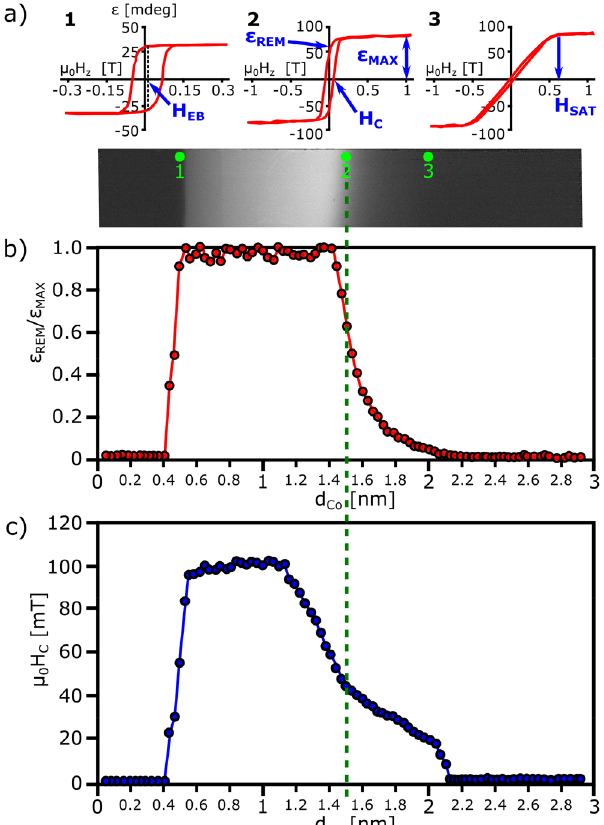
Figure 1. Results of PMOKE measurements. ( a ) Differential PMOKE microscope images registered in remanence after saturation with an out-of-plane magnetic field, where the bright area corresponds to the part of Co layer with PMA. This panel additionally shows the exemplary PMOKE hysteresis loops measured for d Co = 0.5, 1.5, 2 nm (green dots 1 to 3, respectively). On that loops the definitions of characteristic parameters: remanence ( ɛ REM ), ellipticity in maximal magnetic field ( ɛ MAX ) and saturation field ( H SAT ) and exchange bias field ( H EB ) are given graphically; ( b , c ) d Co dependencies of normalized Kerr signal ɛ REM / ɛ MAX and, coercivity ( H C ), respectively. The green dashed vertical line indicates the Co thickness for spin reorientation transition (see Fig.